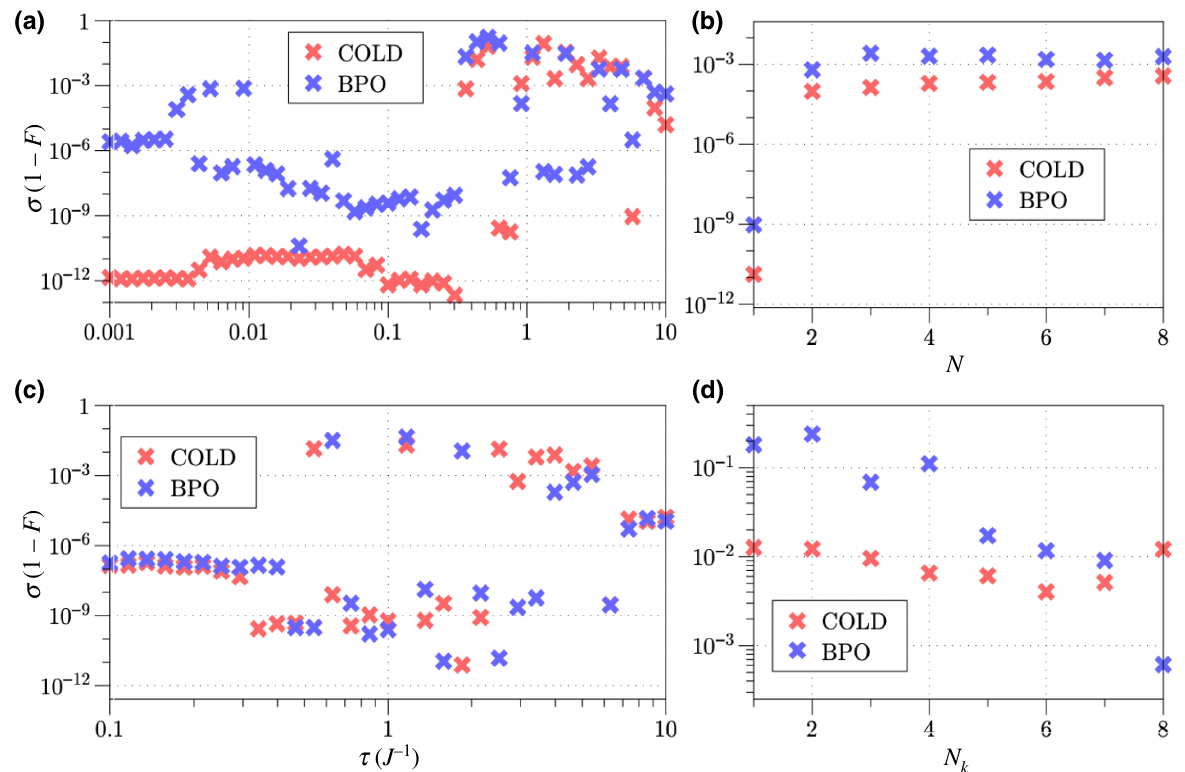
FIG. 9. Plot of the standard deviations from the mean for fidelities after 500 optimizations in the case of COLD and BPO for the Ising spin chain as discussed in Sec. IV. Panel (a) depicts the unconstrained case while (b) shows the constrained case. These correspond to the best result plots in Figs. 2(a) and 5(a), respectively. The plot in (c) gives the standard deviation for increasing lengths of the chain for spin number N while (d) shows the same for an increasing number of parameters N k . As in Fig. 4, both (b) and (c) are plotted for driving time τ = 10 − 2 J − 1 . In all plots, results for COLD are depicted with red crosses while those for BPO are depicted with blue